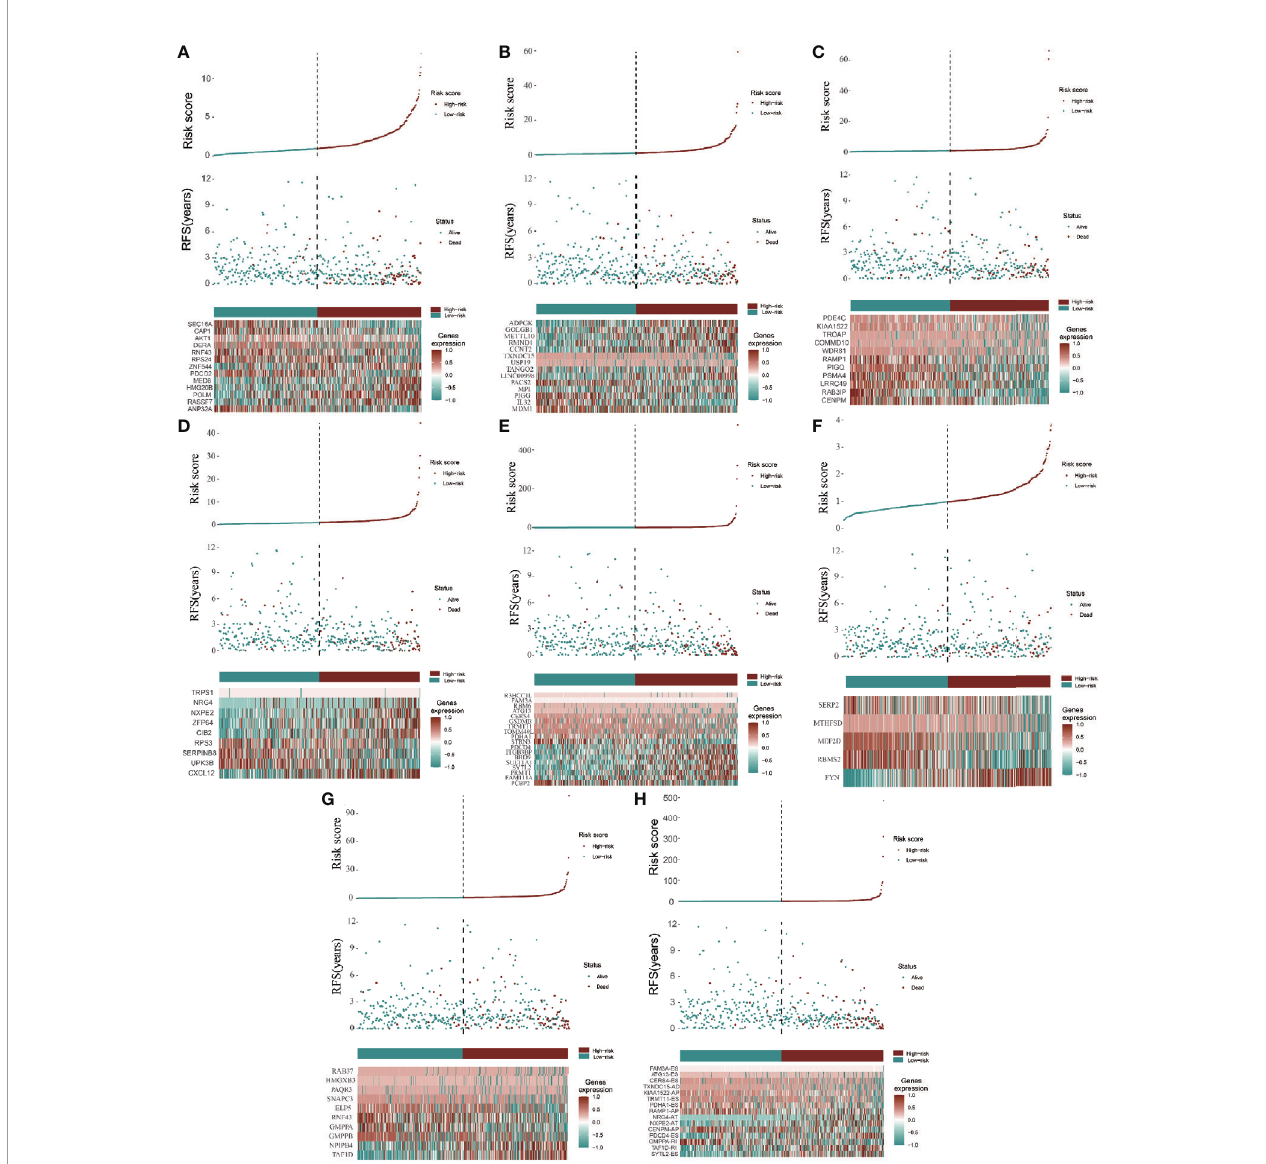
FIGURE 3 | Construction of AS model and distributions. (A – H) represents the AS events AA, AD, AP, AT, ES, ME, RI, and total events, respectively. In each fi gure, the top section shows patient survival data sorted according to the risk levels, the middle section shows the risk score distribution curve, and the bottom section shows the differences in levels of identi fi ed hub immune signatures between high-risk and low-risk groups as a heatmap